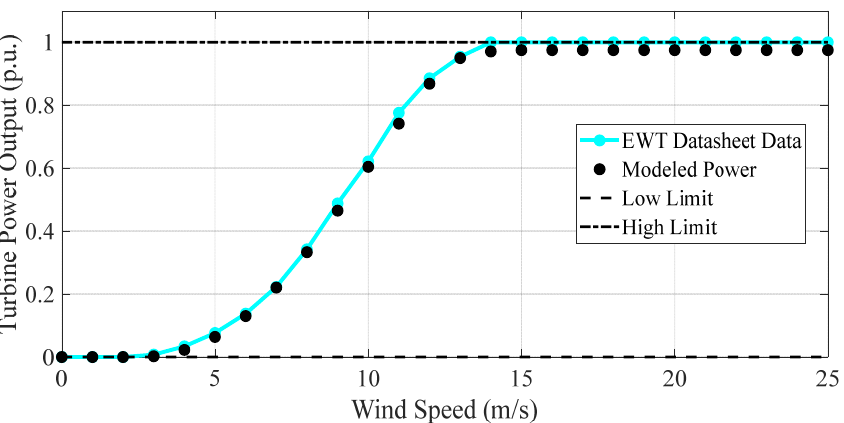
Figure 3. Simulated Wind Power Vs. Wind Speed Curves Compared to Data Provided by EWT.